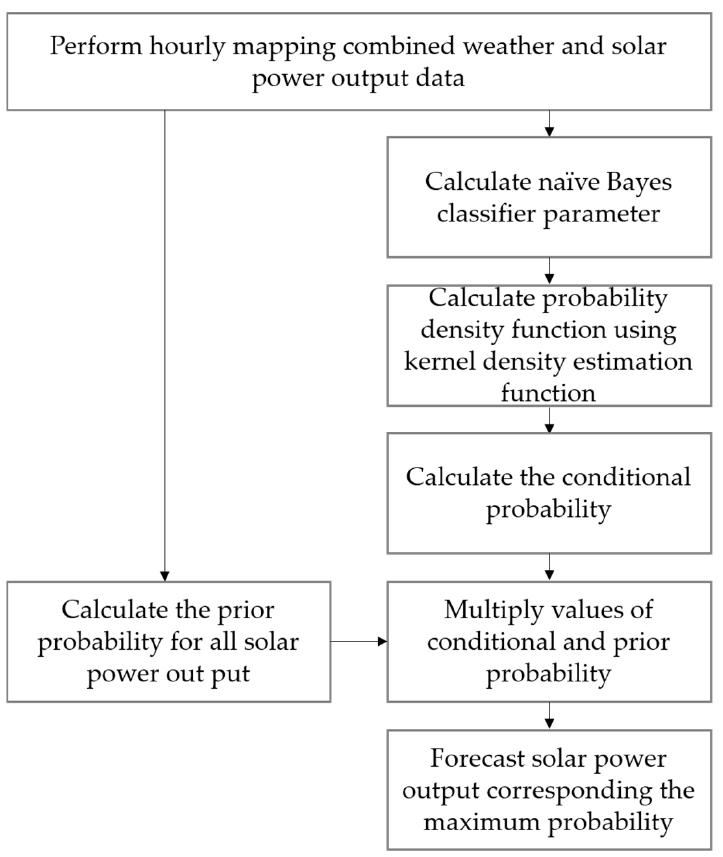
Figure 3. Algorithm for the NBC forecasting model.